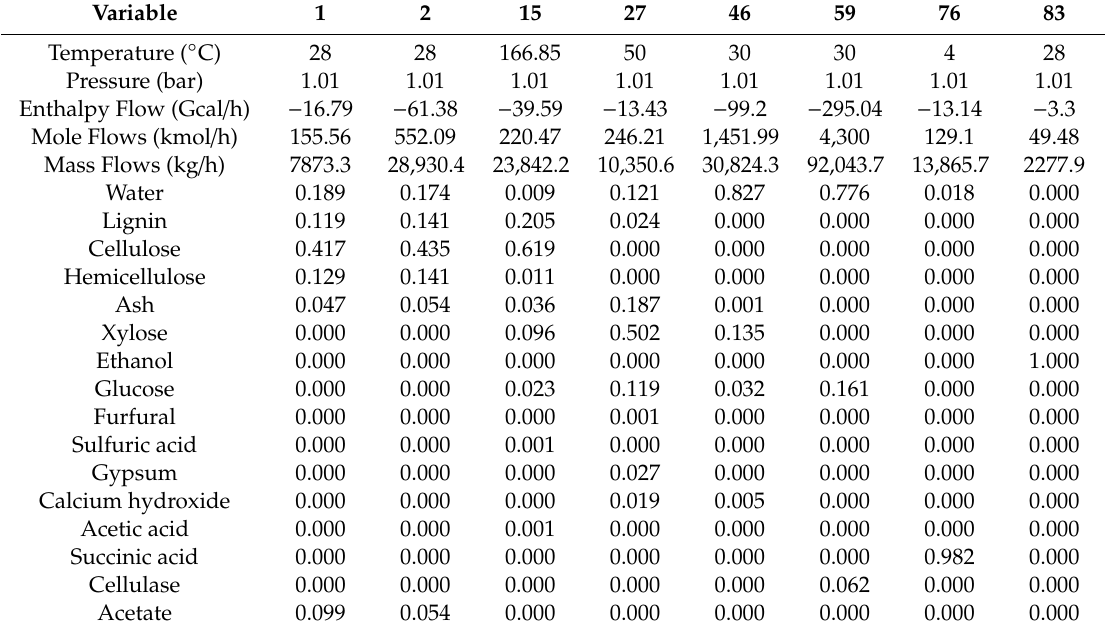
Table 5. Process data of the main streams for topology 2.